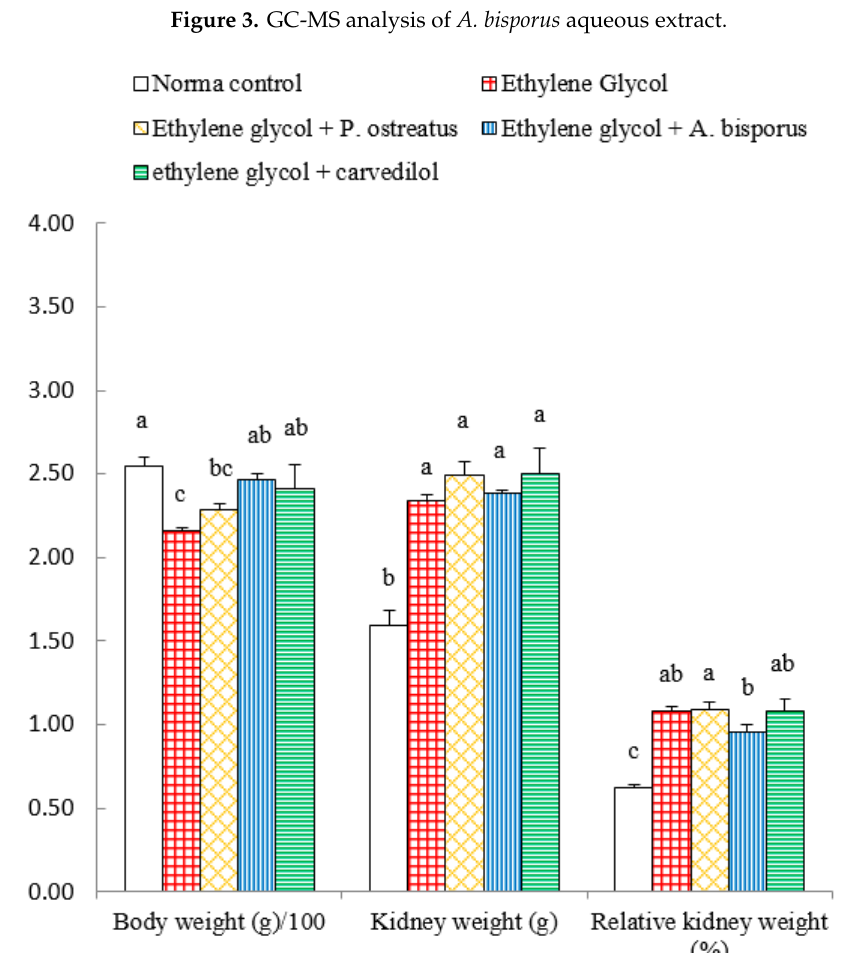
Figure 4. Effect of P. ostreatus and A. bisporus aqueous extracts and carvedilol on body weight, kidney